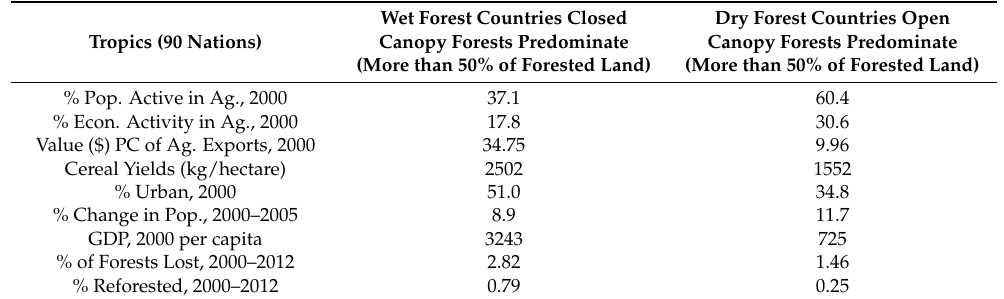
Table 2. Differences between Nations with Closed and Open Canopy Forests * ,† .